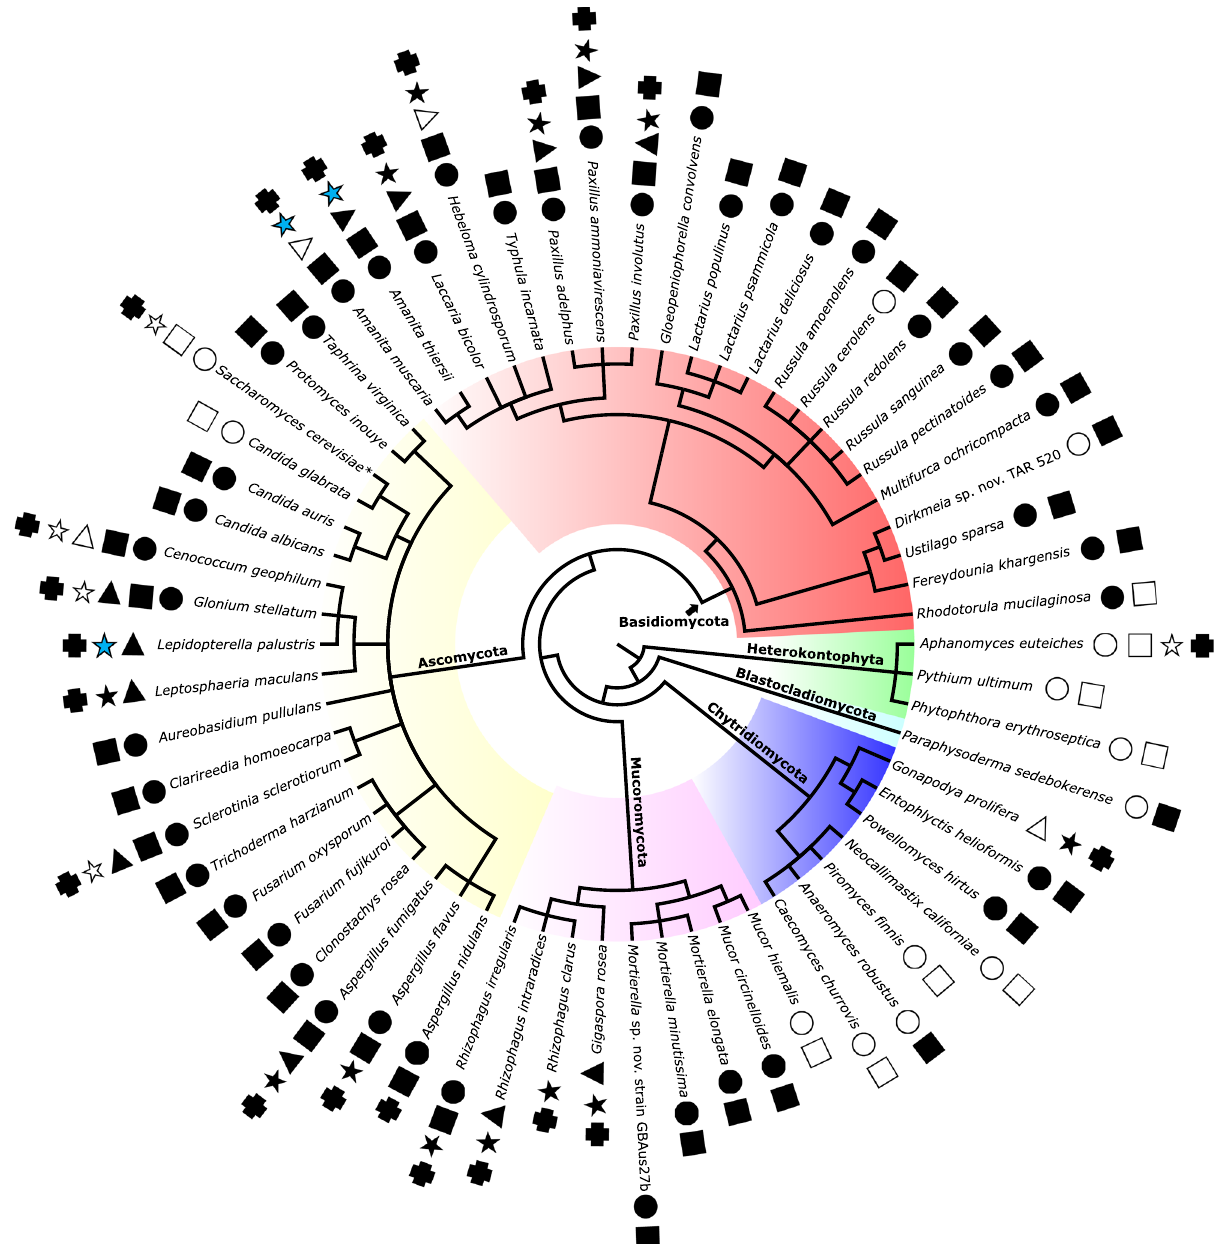
Fig. 1 Production of lipo-chitooligosaccharides and chitooligosaccharides by fungi. Fifty-nine fungi representing fi ve of the eight phyla (indicated by colors) and three species of oomycetes (Heterokontophyta, green) were tested for the presence of lipo-chitooligosaccharide (LCO)s and chitooligosaccharide (CO)s in their culture supernatants. Black circle, detection of sulfated LCOs by the root hair branching assay with M. truncatula . Black square, detection of non-sulfated LCOs by the root hair branching assay with V. sativa . Black triangle, detection of sulfated LCOs in butanol extracts by MtENOD11 expression assay. Black star, detection of LCOs in butanol extracts by LC-MS/MS with high con fi dence (non-targeted mass spectrometry (MS) analysis or two to three MRM transitions per molecule). Blue star, detection of LCOs with lower con fi dence (MS signal at the expected retention time but with only one MRM transition). Black cross, detection of COs by HPLC/MS from water extracts. Clear symbols indicate no detection. Black asterisk indicates two or more strains were